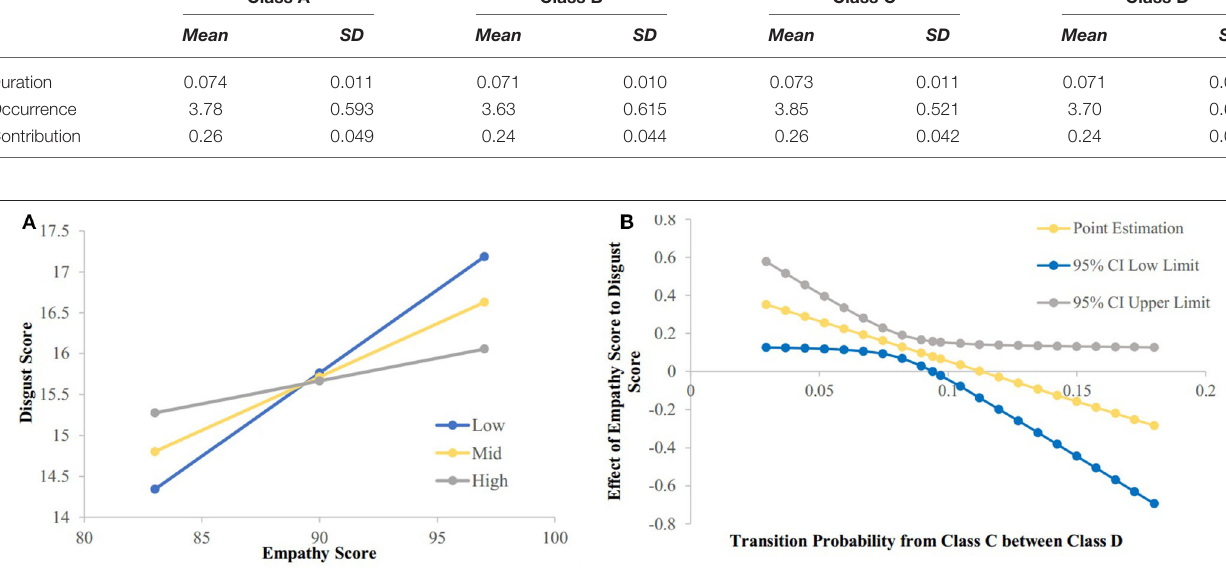
FIGURE 4 | The relationship between empathy score and disgust score were modulated by possibility of transition from class C to class D. (A) Simple slope analysis results showed that: when the disgust score was low (mean-1sd) (sd, standard deviation), the empathy score was significantly positively correlated with the possibility of transition from class C to class D ( p < 0.001); when the disgust score was high (mean + 1sd), the empathy score was no significant correlated with the possibility of transition from class C to class D. (B) Neyman results showed that the disgust score was significantly positively correlated with the empathy score when possibility of transition from class C to class D was below